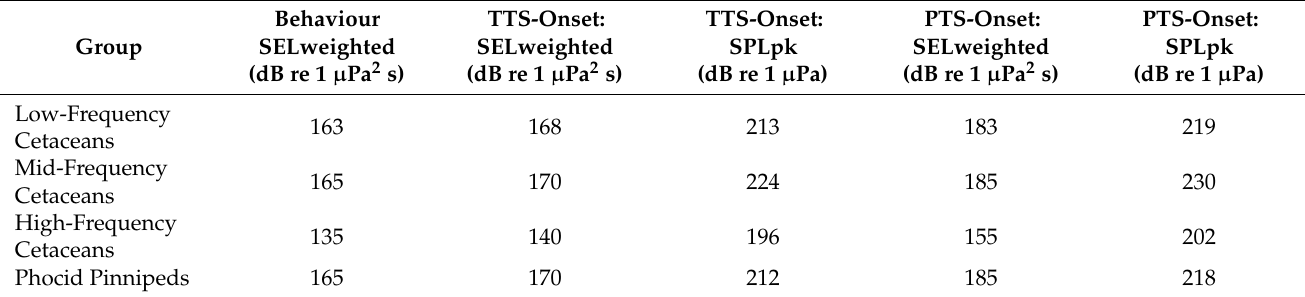
Table 5. Behaviour, TTS and PTS onset dual metric threshold levels for explosives and other impulsive sound sources.